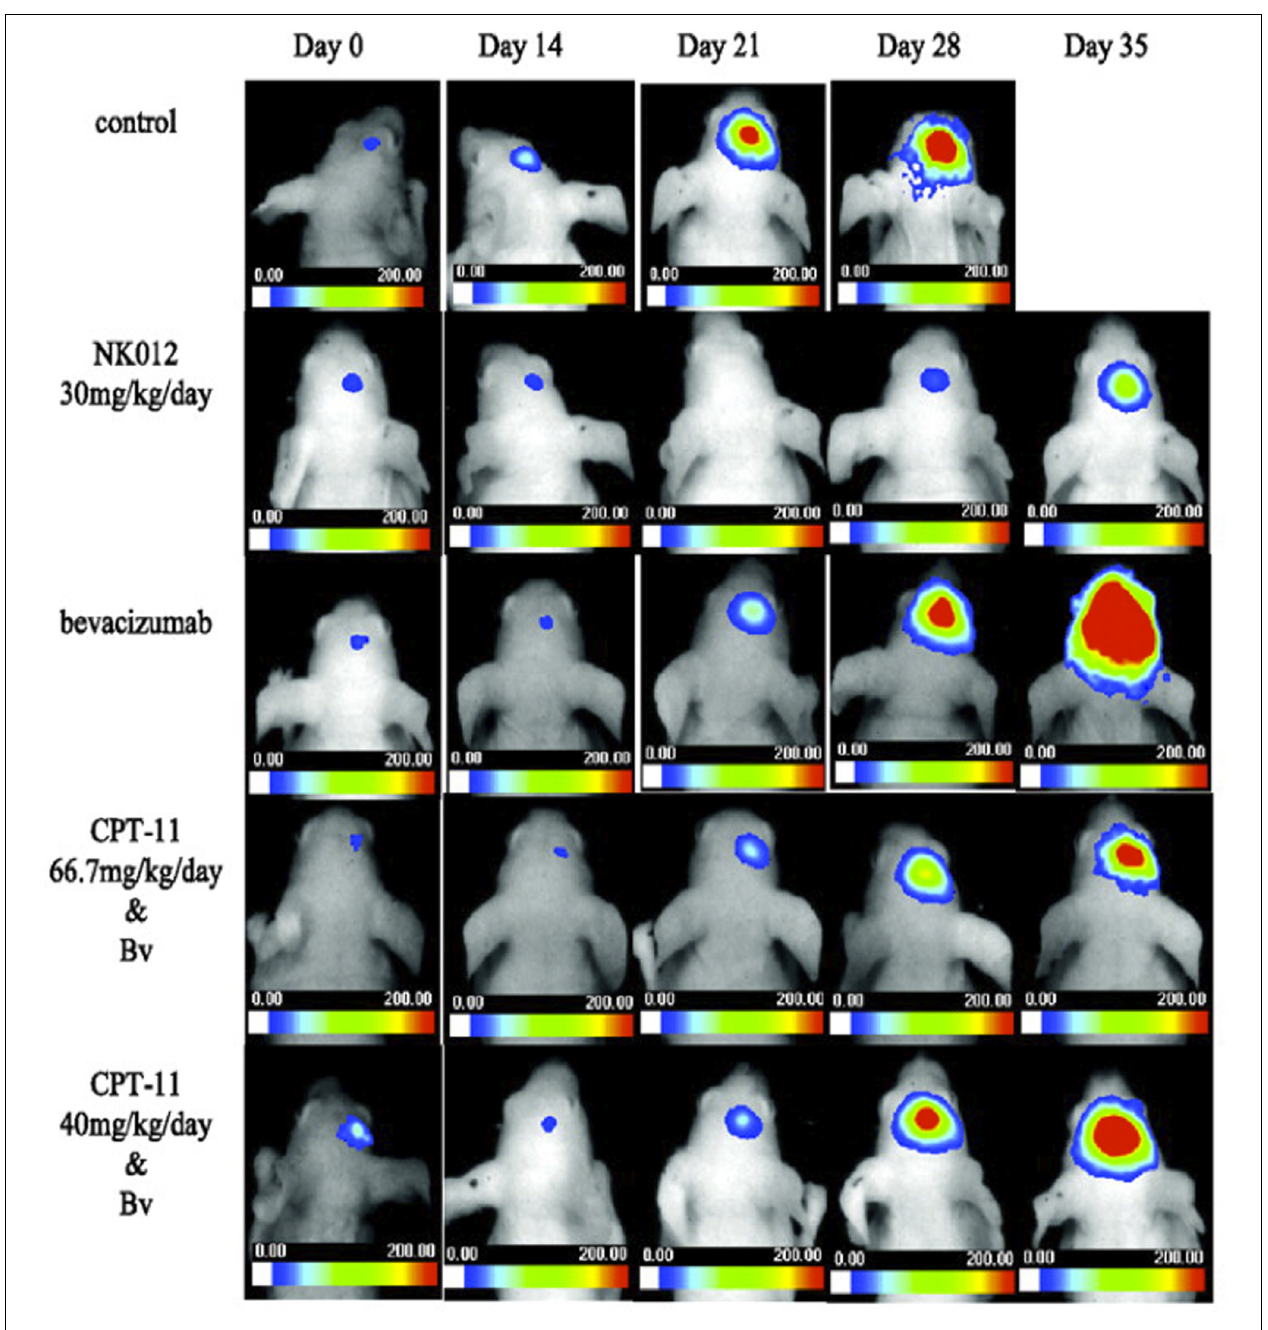
every 4 days. CPT-11 was delivered at 67 or 40 mg/kg three times every 4 days in conjunction with bevacizumab, which was delivered at 5 mg/kg intraperitoneally six times every 4 days. Reproduced with permission from Kuroda etal.